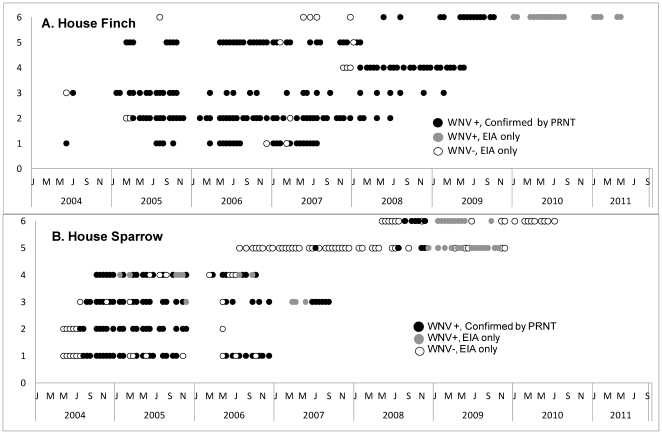
Number of times recaptured birds tested negative, EIA positive, and EIA and PRNT positive.Data are shown for 6 House Finches and 6 House Sparrows collected on multiple occasions.